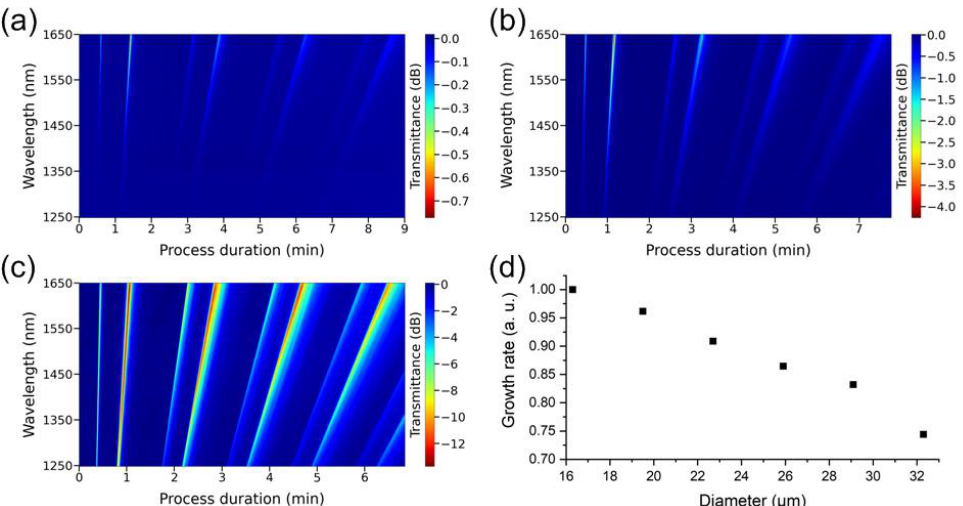
Figure 10. Spectral response in the wavelength range of 1250 – 1650 nm depending on the duration of the synthesis process of ZnTe film on the surface of a thinned optical fiber with an outer diameter of ( a ) 32.3 µm ( b ) 25.9 µm ( c ) 16.3 µm. ( d ) Dependence of the normalized rate of coating deposition on the outer diameter of the etched fiber region.